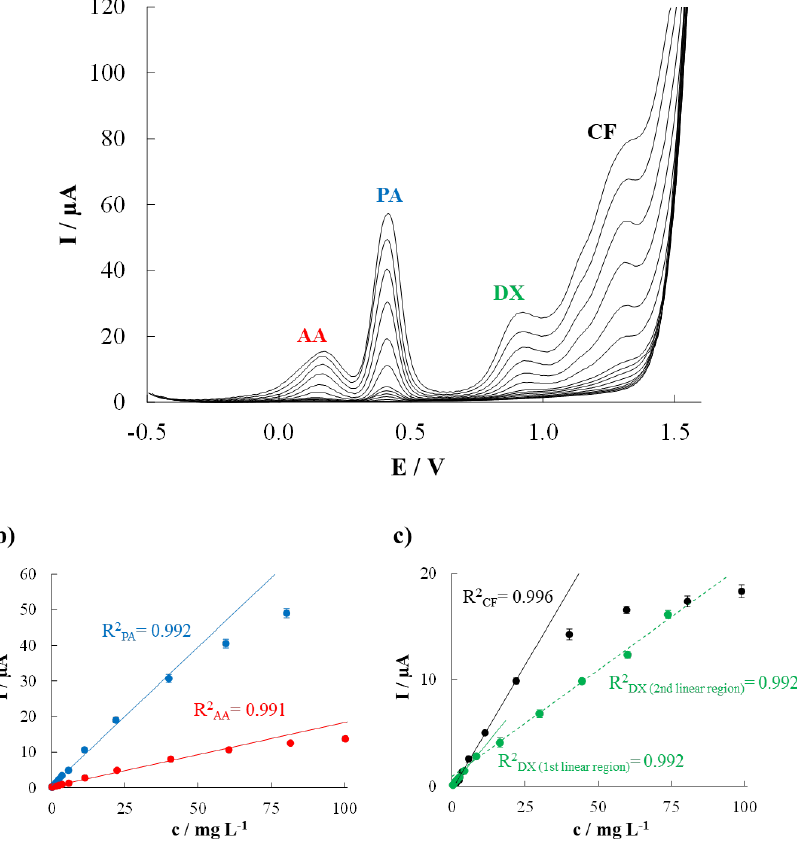
Figure 3. ( a ) Simultaneous DP voltammograms of ascorbic acid, paracetamol, dextromethorphan and caffeine; and the calibration plots of ascorbic acid and paracetamol ( b ) and dextromethorphan and caffeine ( c ) in 0.1 mol L −1 acetic/acetate buffer pH 5.00 on SPCE. Error bars in the calibration plots represent the standard deviations from replicate calibration curves carried out with three dif- ferent electrodes.